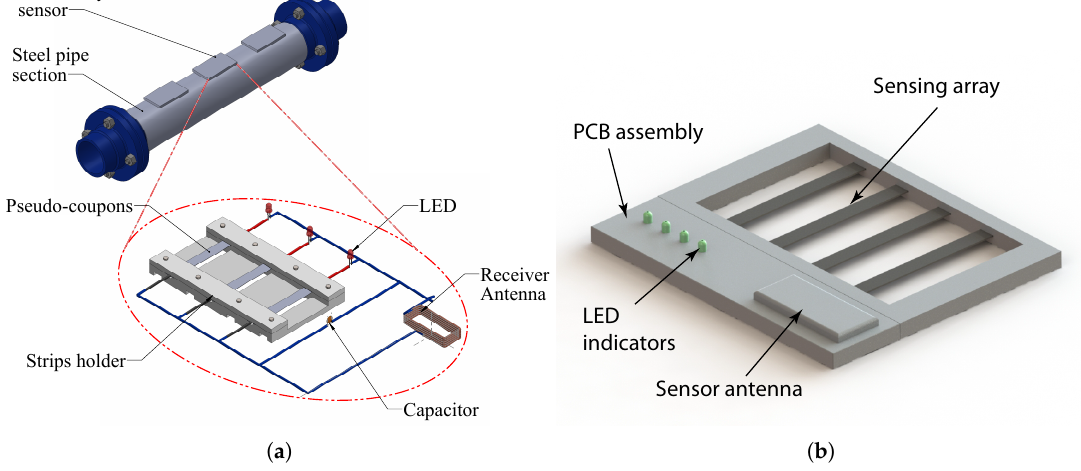
Figure 1. Schematic of the proposed sensor design. ( a ) sensor diagram; ( b ) sensor packaged for field